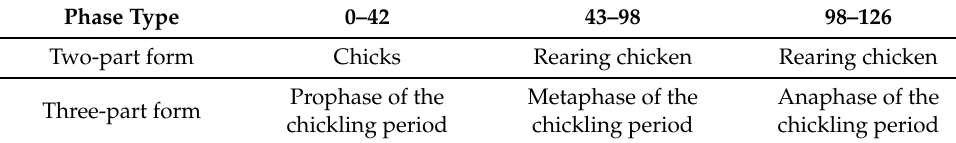
Table 1. Information about chickens in diverse classification